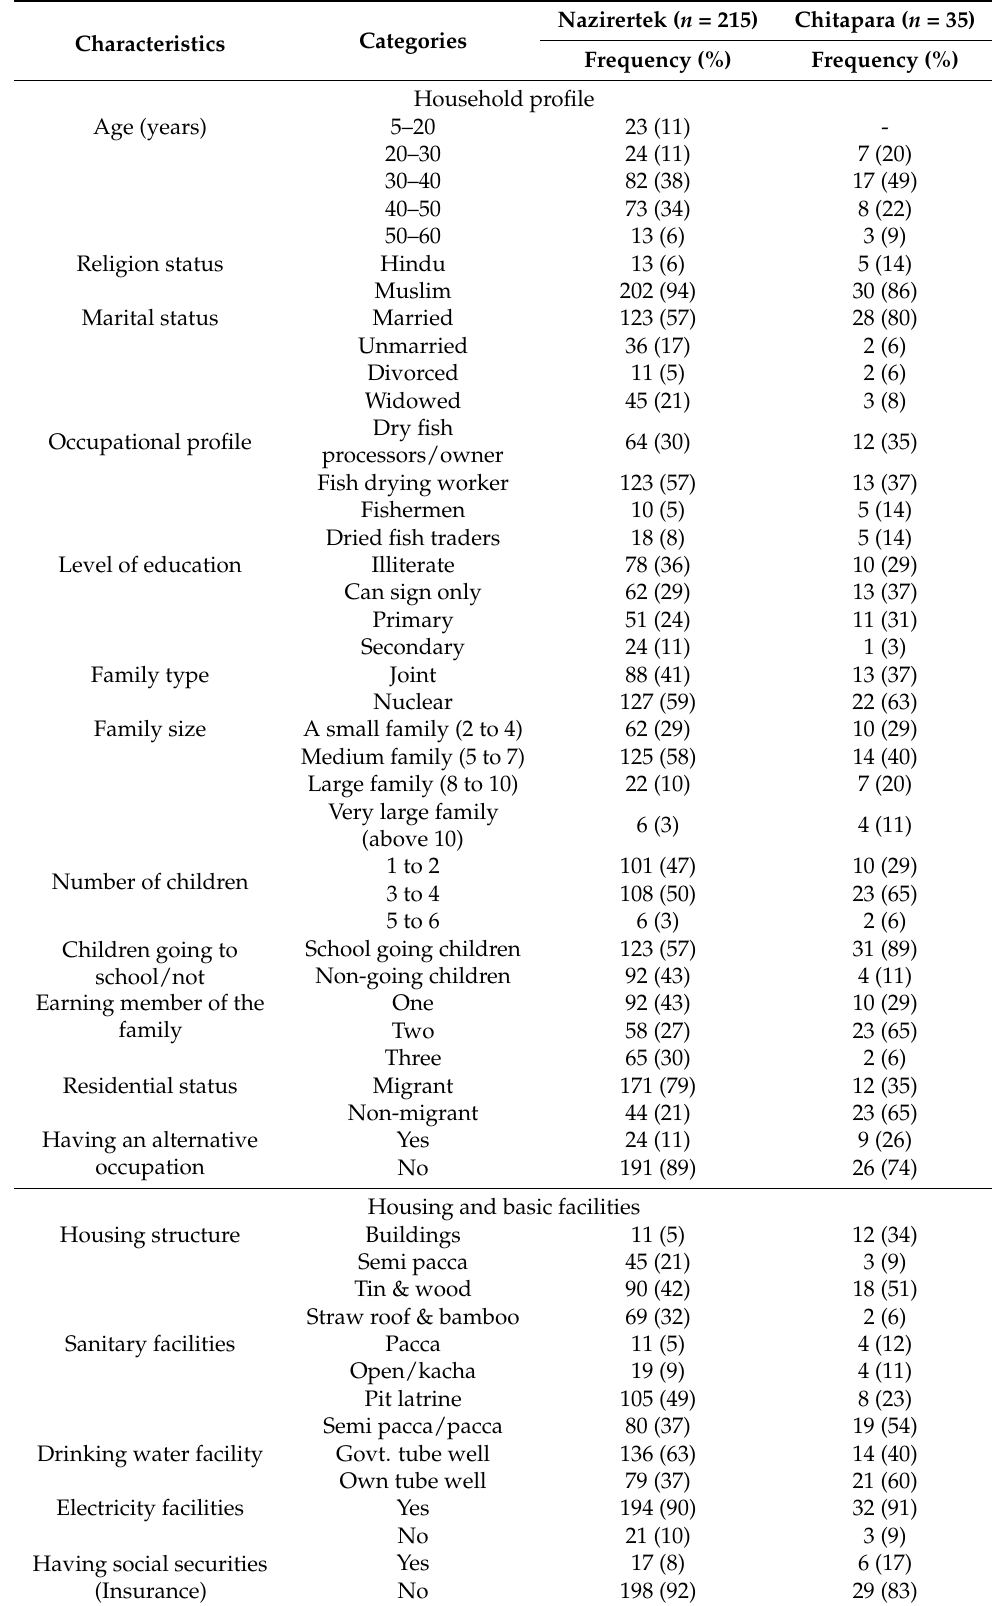
Table 3. Summary of the communities’ socio-demographic profile involved in fish drying activities in the study areas ( N =